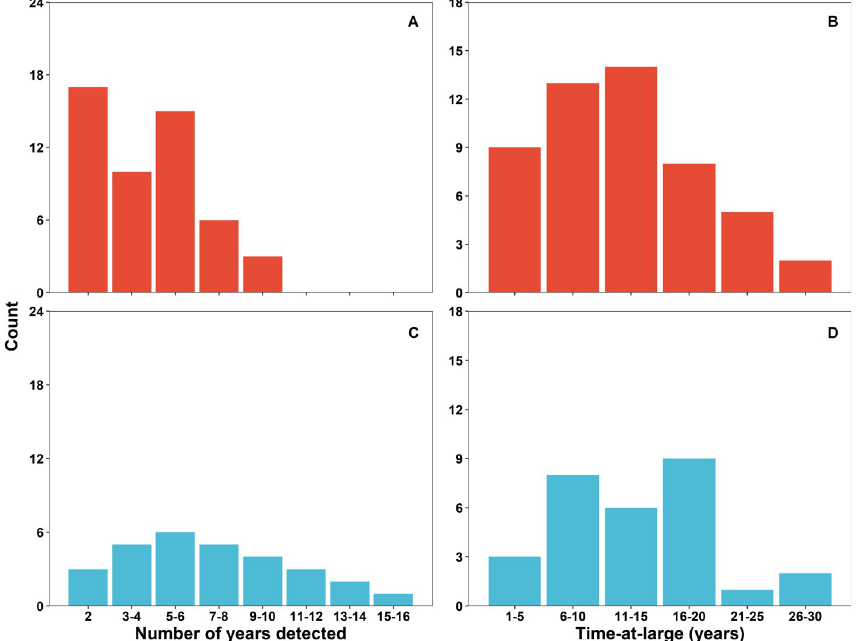
Fig 4. Nurse shark long-term use of the Dry Tortugas courtship and mating ground. For returning sharks only, a) and b) the number of mating seasons detected per shark over the course of the study and c) and d) the time-at-large (in years) for these sharks, defined as the most recent year of detection minus the first year in the study. Female = red fill (N = 51) and male = blue fill (N = 29). These returns reflect sharks tagged between 1993 and 2014, with return observations made through the mating season,